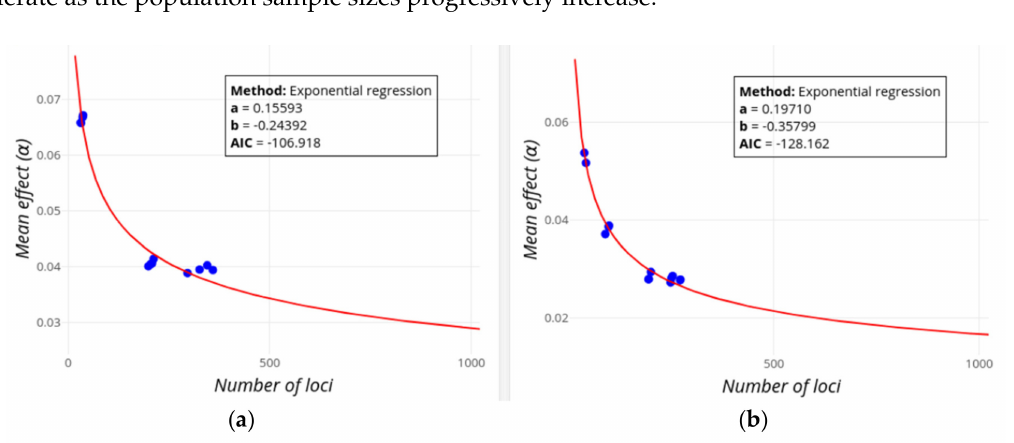
Figure 3. Screenshot of GWEHS (Genome-Wide E ff ect size and Heritability Screener) showing the inferences on the decrease of the mean e ff ect size as new loci are found, using the default parameters (up to 1000 loci). Blue points indicate observed values from di ff erent sets of PubmedIDs (PMIDs). The red line corresponds to the regression fit. A text box includes the distribution parameters and the Akaike information criterion (AIC) value. ( a ) Inferences for Height. ( b ) Inferences for Digestive disease (Crohn’s disease and Inflammatory bowel